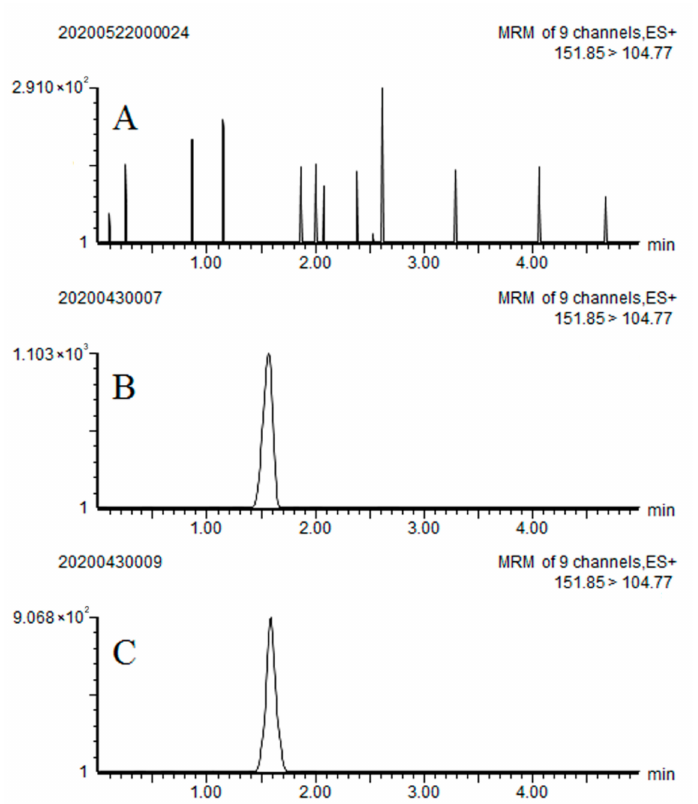
Figure 2. Typical liquid chromatography tandem mass spectrometry/multiple reaction monitor- ing LC-MS/MS MRM chromatograms of benziothiazolinone in apple samples: ( A ) blank sample; ( B ) matrix standard at 0.01 mg/kg; and ( C ) spiked sample at 0.01 mg/kg.